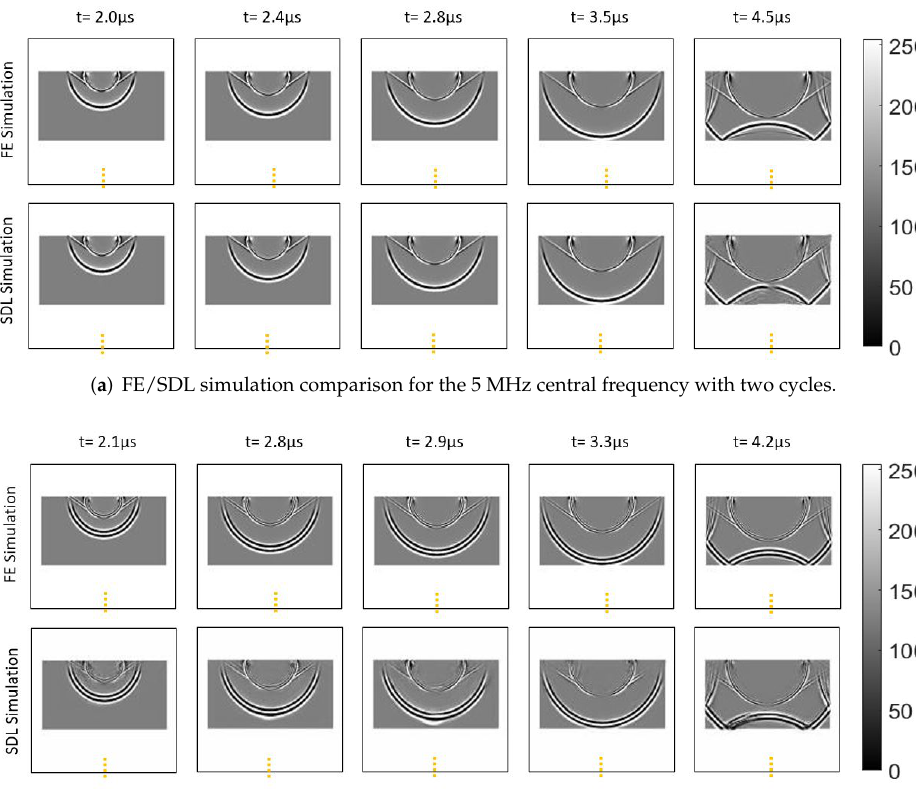
Figure 10. Reflected wave propagation with a varying number of cycles: A qualitative comparison between the FE and SDL simulations modeled in the rectangular domain, with the varying number of cycles with a 5 MHz central frequency with a single-point excitation source on the top edge. ( a ) represents the simulation of two cycles, and ( b ) illustrates the simulation of three cycles, at identical time